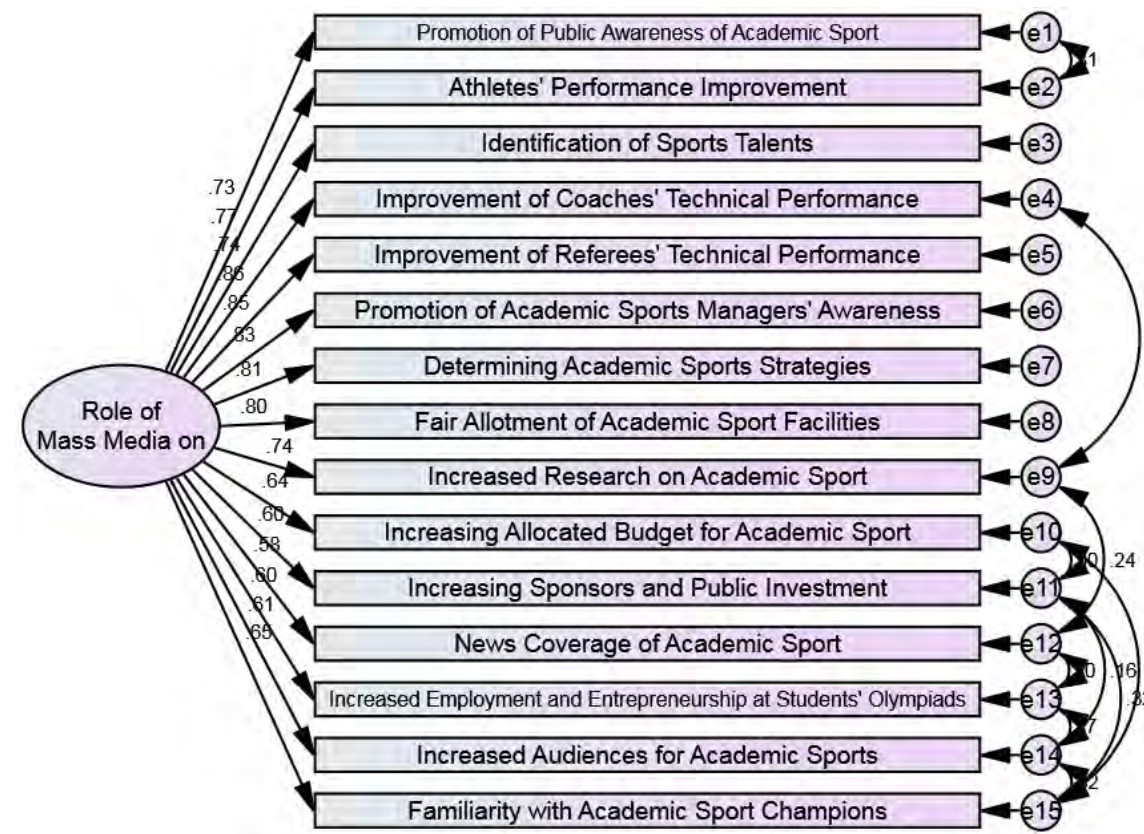
Figure 1. Measurement Model for Level of Influence of Mass Media on Iran's Female Academic Sport